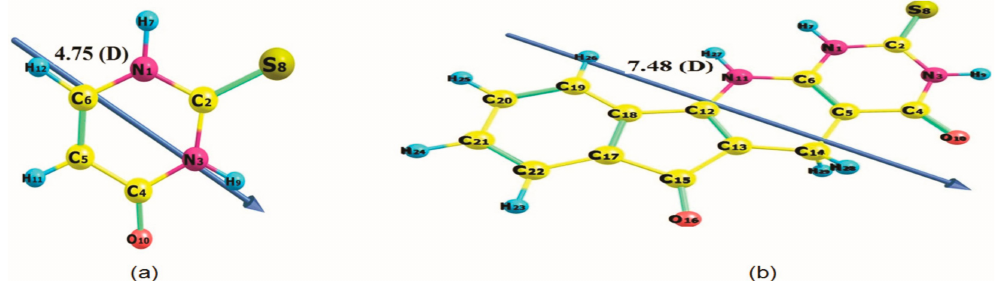
Figure 3. Optimized geometry, numbering system, vector of dipole moment, value of dipole moment (D) of ( a ) thiouracil nucleus and ( b ) compound 1H at B3LYP / 6-311 ++ G ( d , p ) level of calculation. Table 1. Experimental bond length and computed values of thiouracil (TU) nucleus at di ff erent levels of calculations. 6-311 ++ G (d, p) Parameters Exp.*